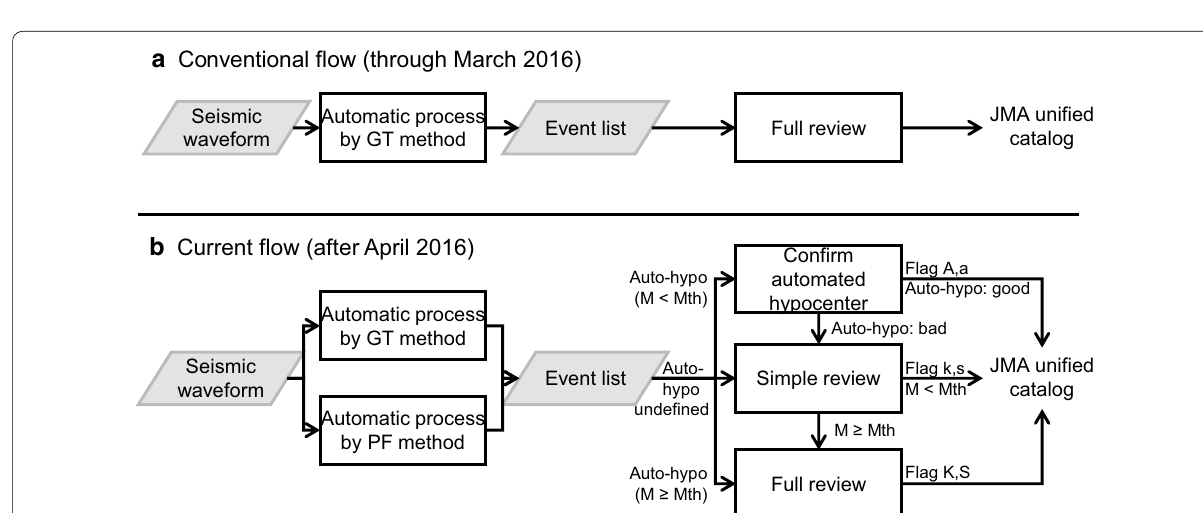
Fig. 3 Flowchart of the production of the JMA unified catalog: a conventional flow (before April 2016) and b current flow (after April 2016). “Auto-hypo” means the automatically processed hypocenter. The flow from “Event list” to “Simple review” indicates the GT event without automatically processed